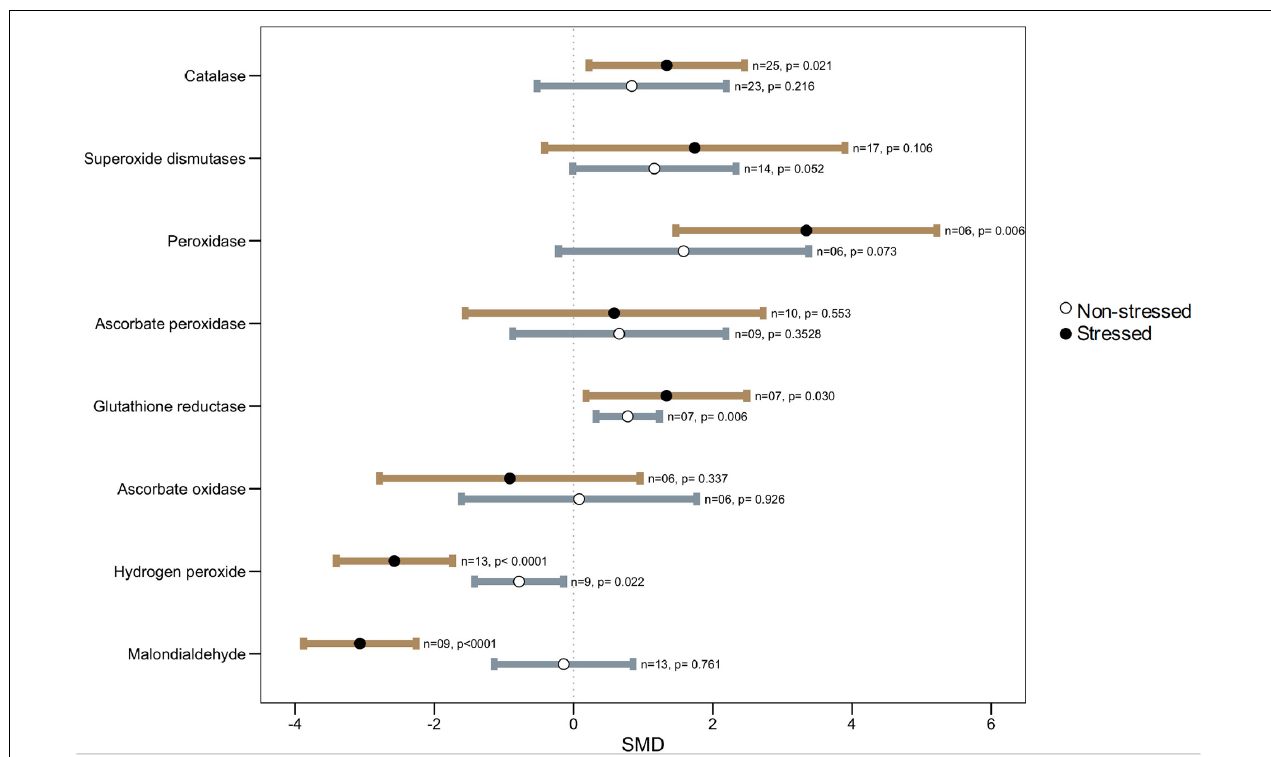
FIGURE 6 | Effects of microbial inoculation on plant ROS production and antioxidant enzymatic activity under non-stressed, and heat stress. Error bars are means ± 95% CIs. Where the CIs do not overlap the vertical dashed lines, the effect size for a parameter is significant. n = number of studies included in the meta-analysis, p = significance level of